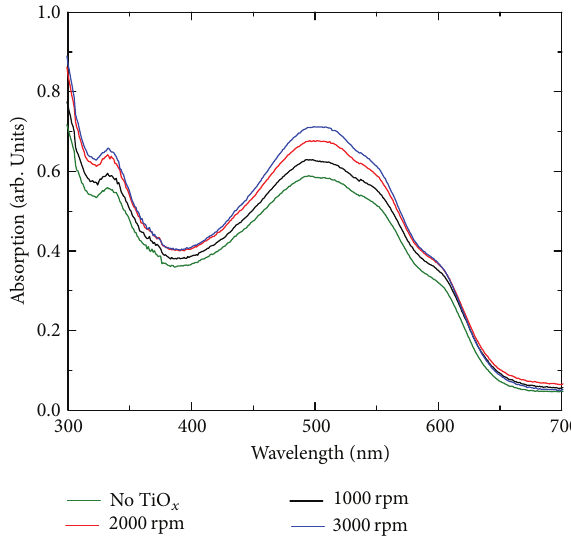
Figure 2: UV-Vis absorption profile of P3HT:PC 61 BM with/with- in which TiO was spin-casted at different spin speeds of out TiO x x 1000, 2000, and 3000 rpm.